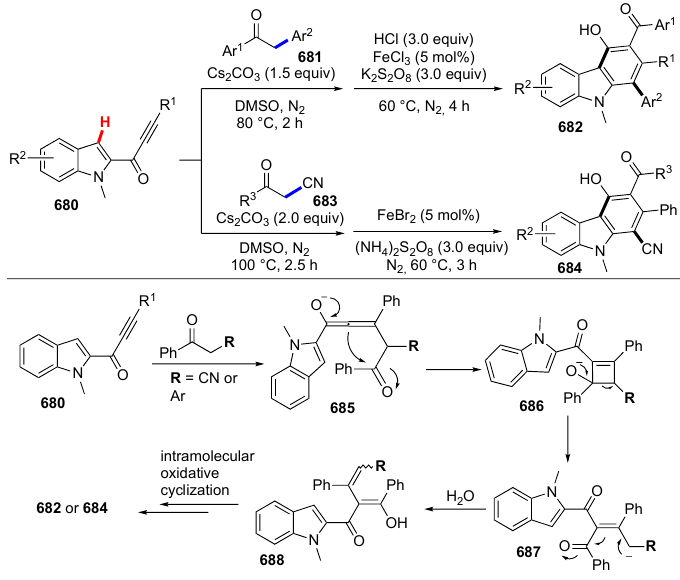
Scheme 88. Base-mediated synthesis of carbazoles.